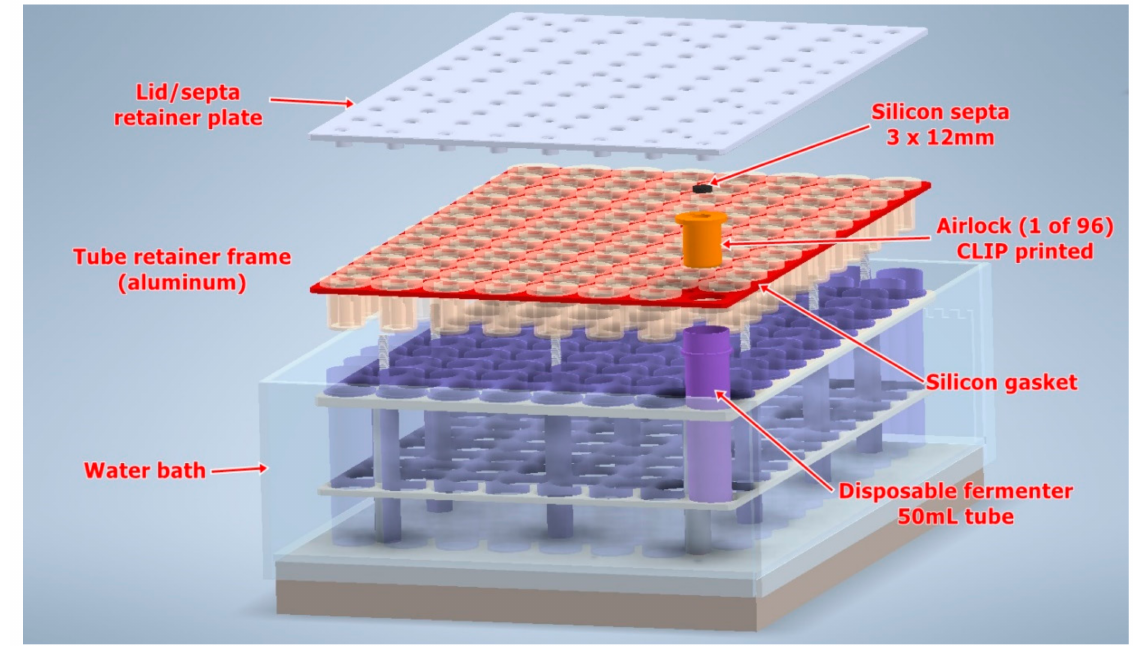
Figure 2. 96 × 30 mL rack and airlock assembly (1 of 4) used to house 96 fermentation